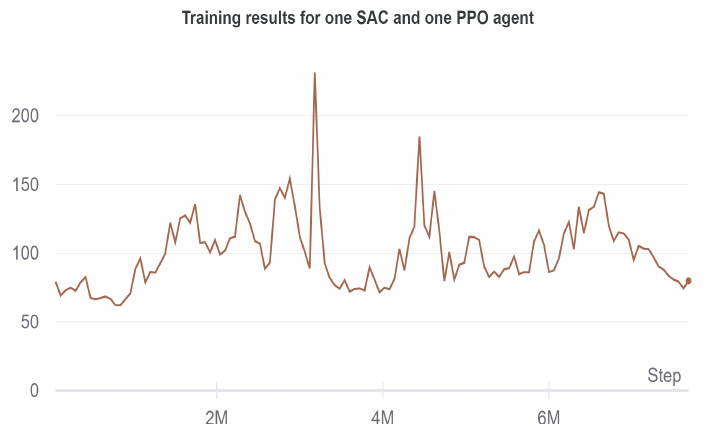
Figure 9. Progression of the accumulated reward for one SAC and one PPO agent.